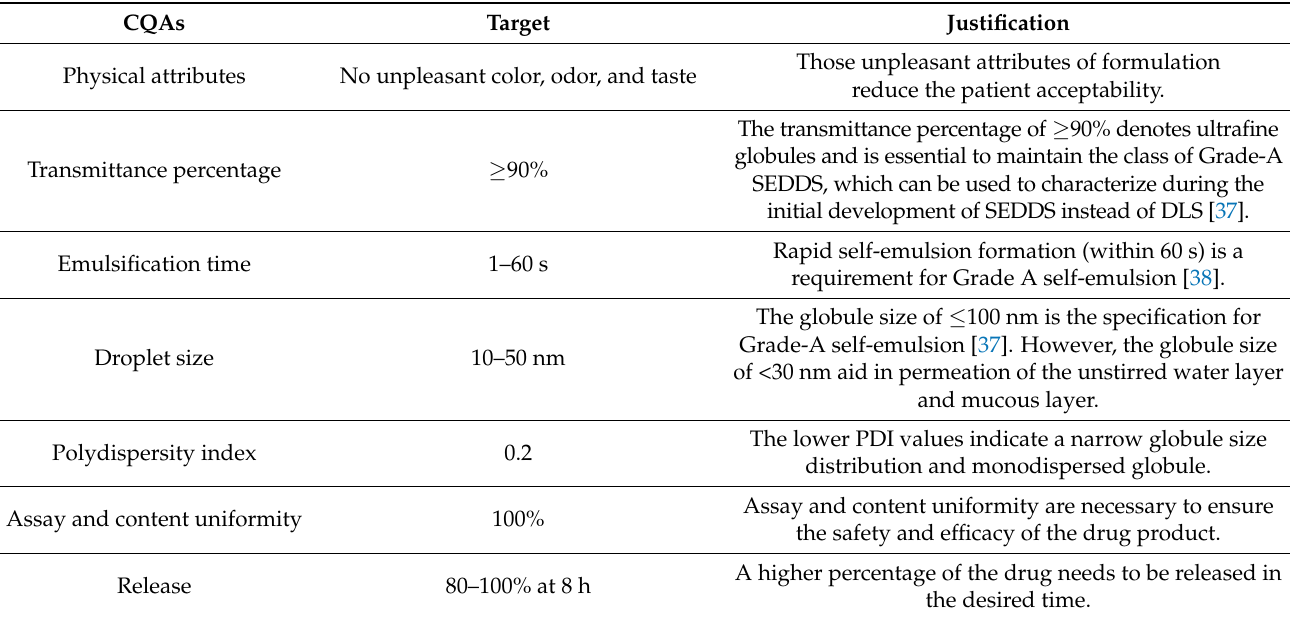
Table 2. QAs with their targets and